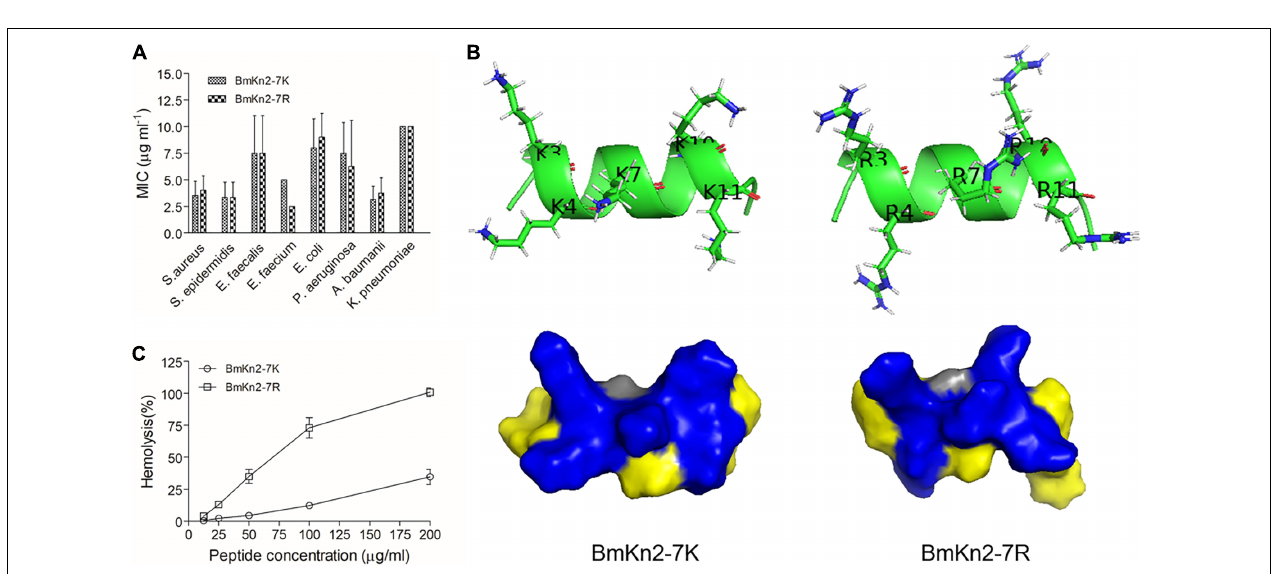
FIGURE 7 | Structural and functional comparison of BmKn2-7K and BmKn2-7R. (A) No significant difference in the MIC values was observed between BmKn2-7K and BmKn2-7R. (B) Compared with BmKn2-7R, BmKn2-7K shows much lower hemolytic activity. (C) Compared with BmKn2-7R, BmKn2-7K shows a distinct structure surface view and side chain orientations on the hydrophilic